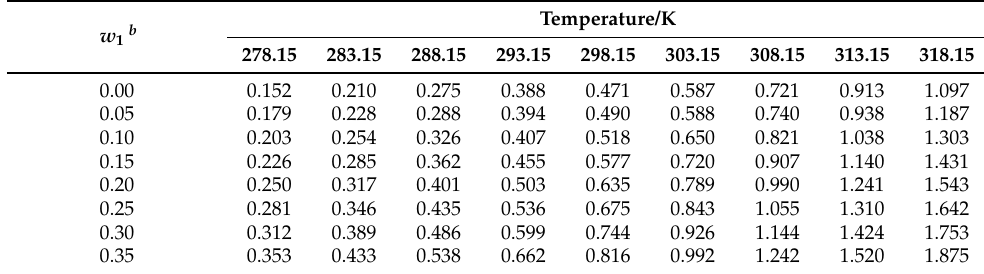
Table 2. Experimental solubility of sulfadiazine (3) in {acetoitrile (1) + 1-propanol (2)} cosolvent mixtures expressed in mole fraction (10 4 x 3 ) at different temperatures and p = 96 kPa ac